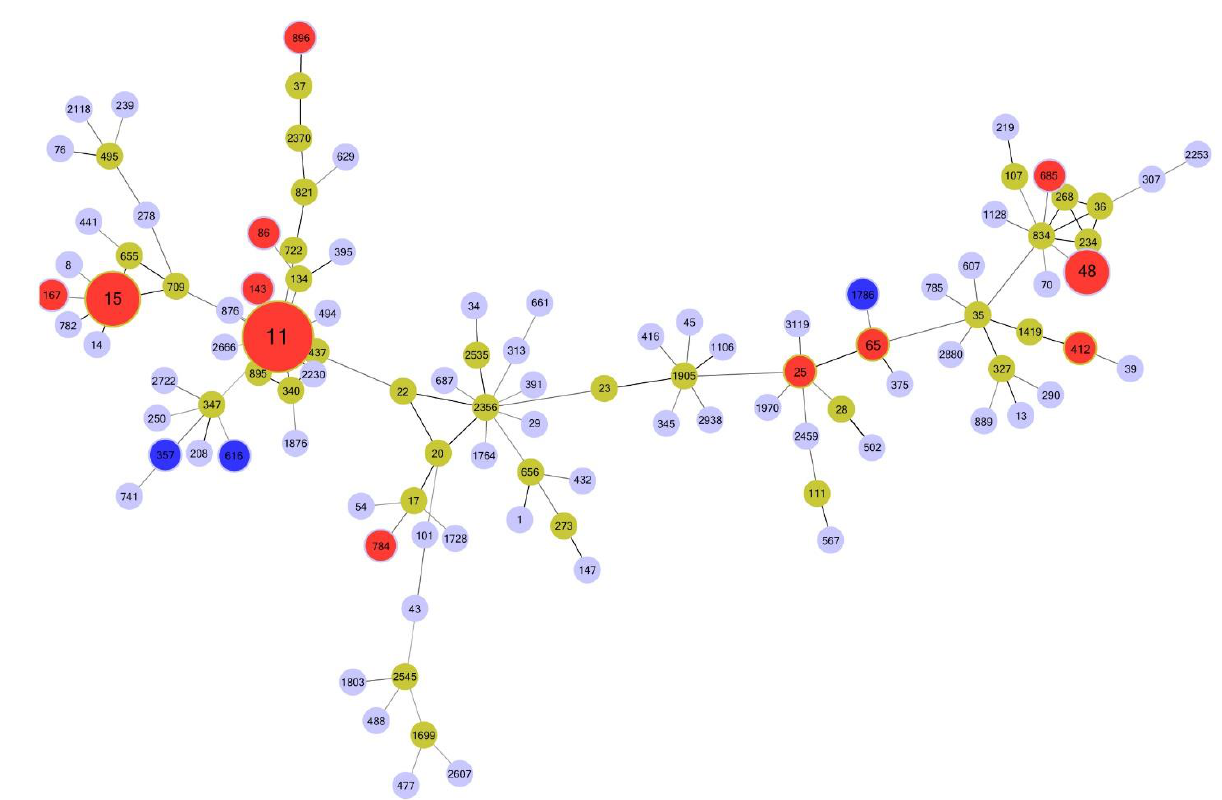
Figure 2. Minimum spanning tree of multi-locus sequence typing (MLST) of Klebsiella pneumoniae collected from 2012 to 2020. Each circle (node) represents multiple identical sequences. Circle diameter in red is based on the number of isolates on a log scale. Red and blue represent Klebsiella pneumoniae ST type in this study. Blue is ST type not reported in the CRE-Network study [5].